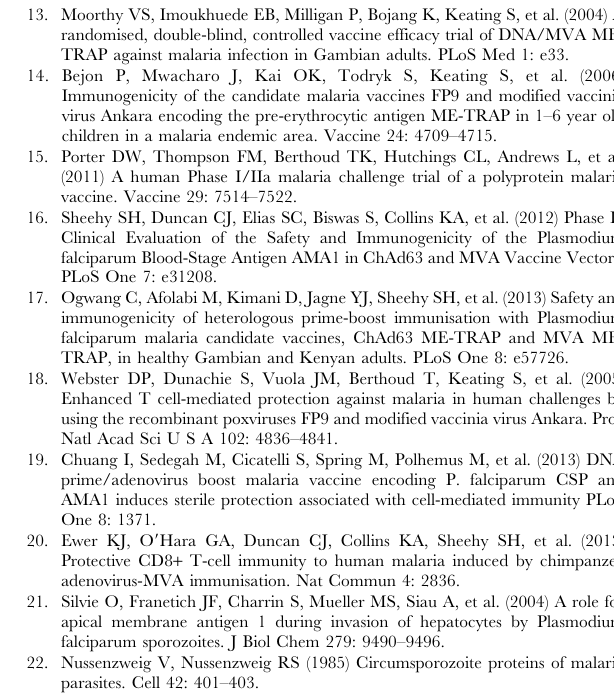
Figure S6 DNA/Ad: Pre- and post-challenge T cell responses to CSP and AMA1 peptide pools. The T-cell activities of protected volunteers v06, v10, v11 and v18 to CSP and AMA1 peptide pools were measured 22/23 days after the Ad boost, 5/6 days before malaria challenge (1), 28 days (2) and 84 days (3) after malaria challenge. Panels A and B: ELISpot activities; Panels C and D: CD8 + T cell EM IFN- c activities. With ELISpot and CD8 + T cell EM IFN- c activities at 28 days after challenge of protected volunteer v11 fell with Cp9, v11 fell with Cp6, v10 and v18 fell with Ap8 and v11 fell with Ap10, and all activities generally declined further by 84 days after challenge. In contrast ELISpot activities of non-protected volunteers all rose at 28 days after challenge, and then declined by 84 days after challenge (not shown); CD8 + T cell EM IFN- c activities remained negative after challenge. Therefore, after challenge ELISpot pool- specific activities and CD8 + T cell EM IFN- c activities, although